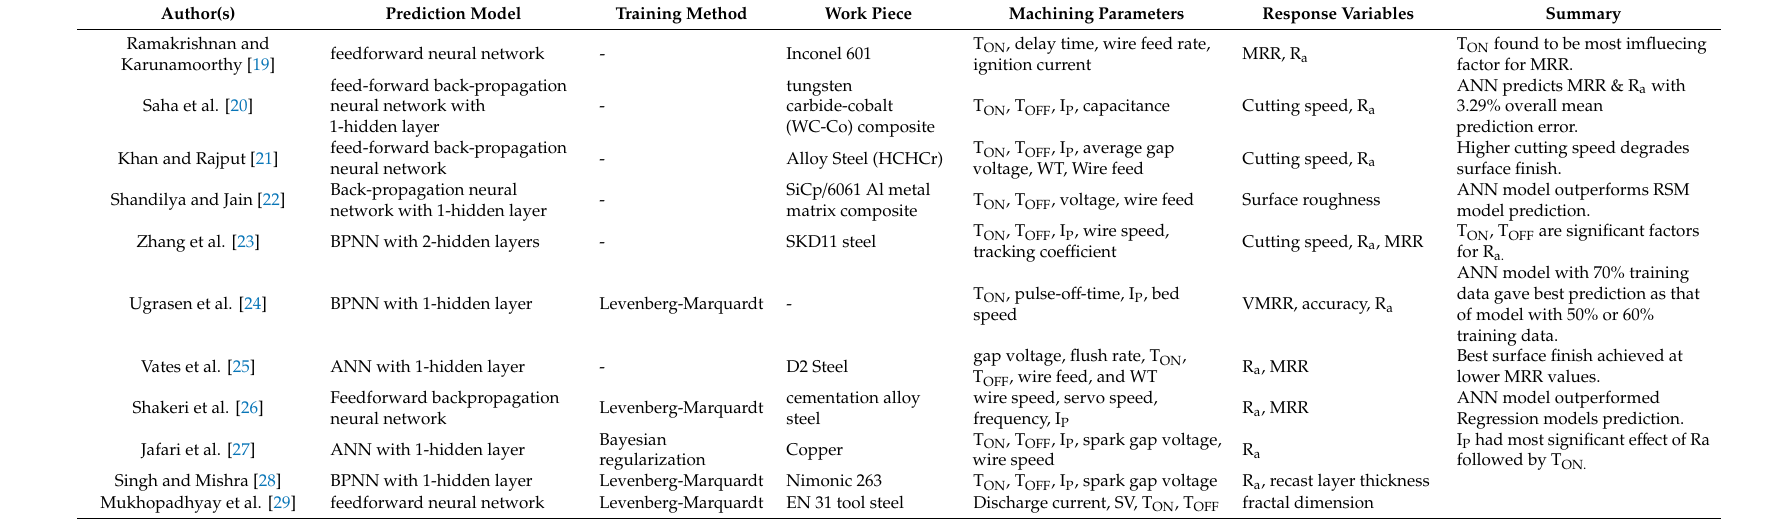
Table 1. Previous research on application of ANN in modelling